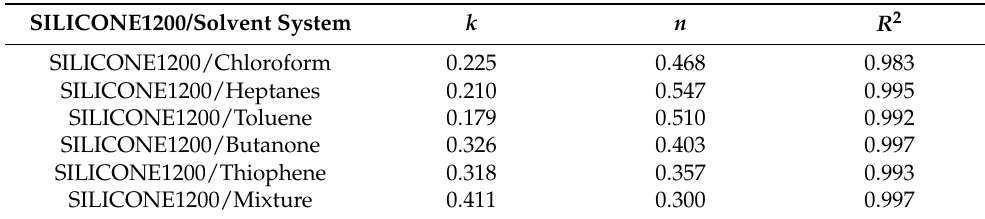
Table 7. k and n values of the different SILICONE1200 membrane–solvent systems obtained from the curves in Figure